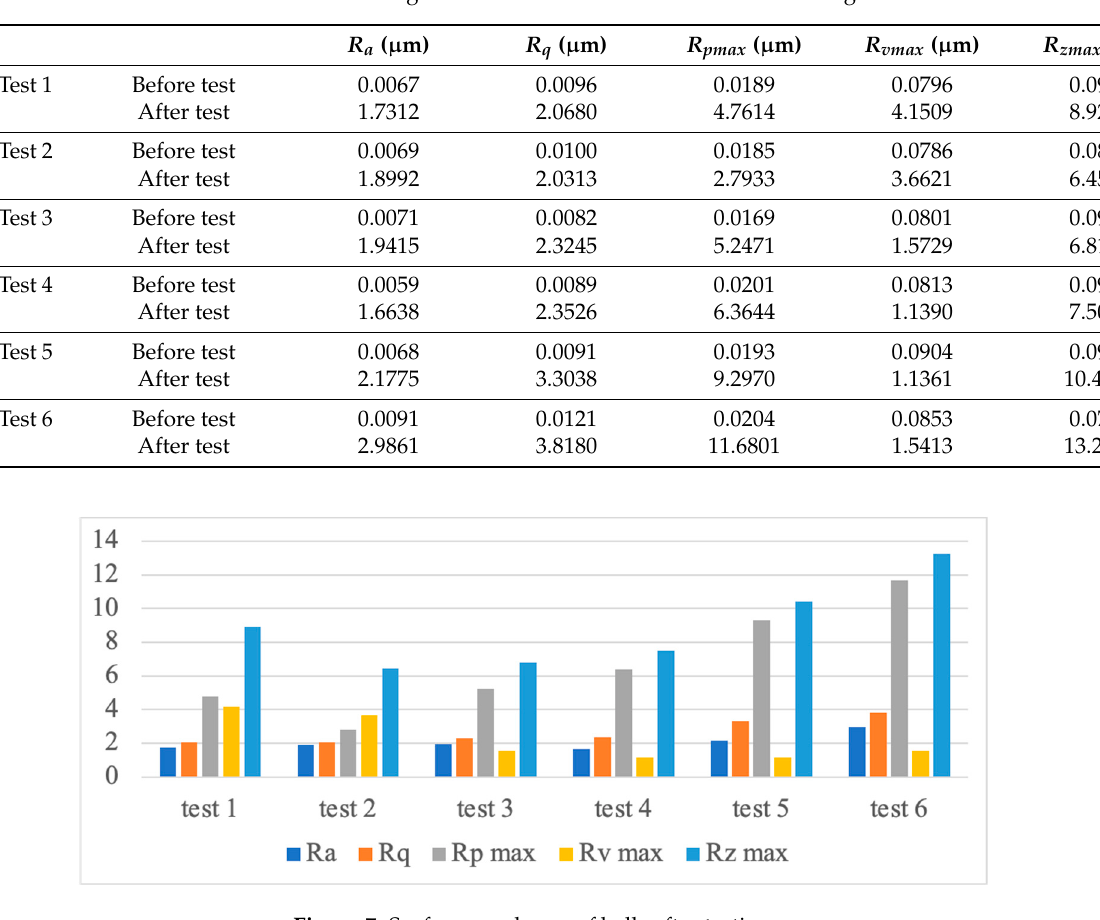
Table 8. Surface roughness values of disks before testing. R a (µm)